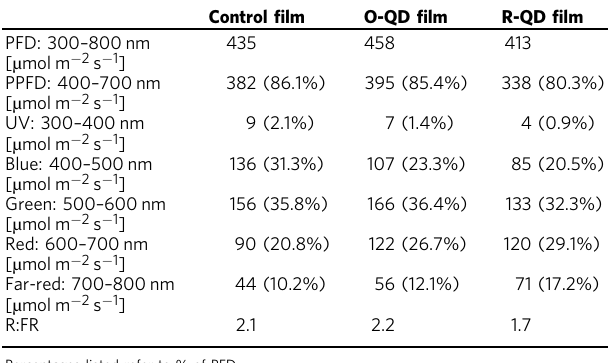
Table 1 Characterization of light intensities and spectral distribution from 300 to 800 nm under QD and Control fi lms in the PGTC prior to